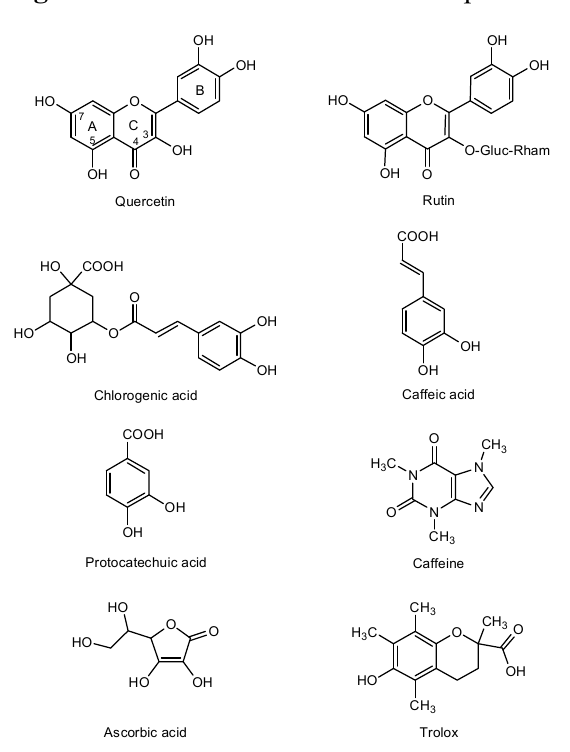
Figure 1. Structures of the tested